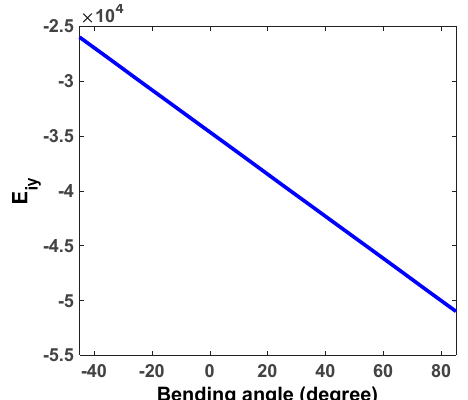
Figure 7. Dependence of the amplitude of the electromagnetic waves applied by the electric field on the bending angle.